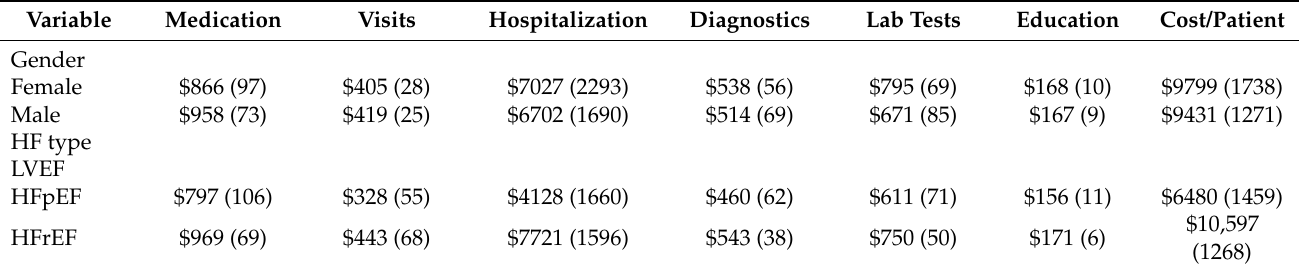
Table 2. The average annual direct medical costs by components per HF patient.